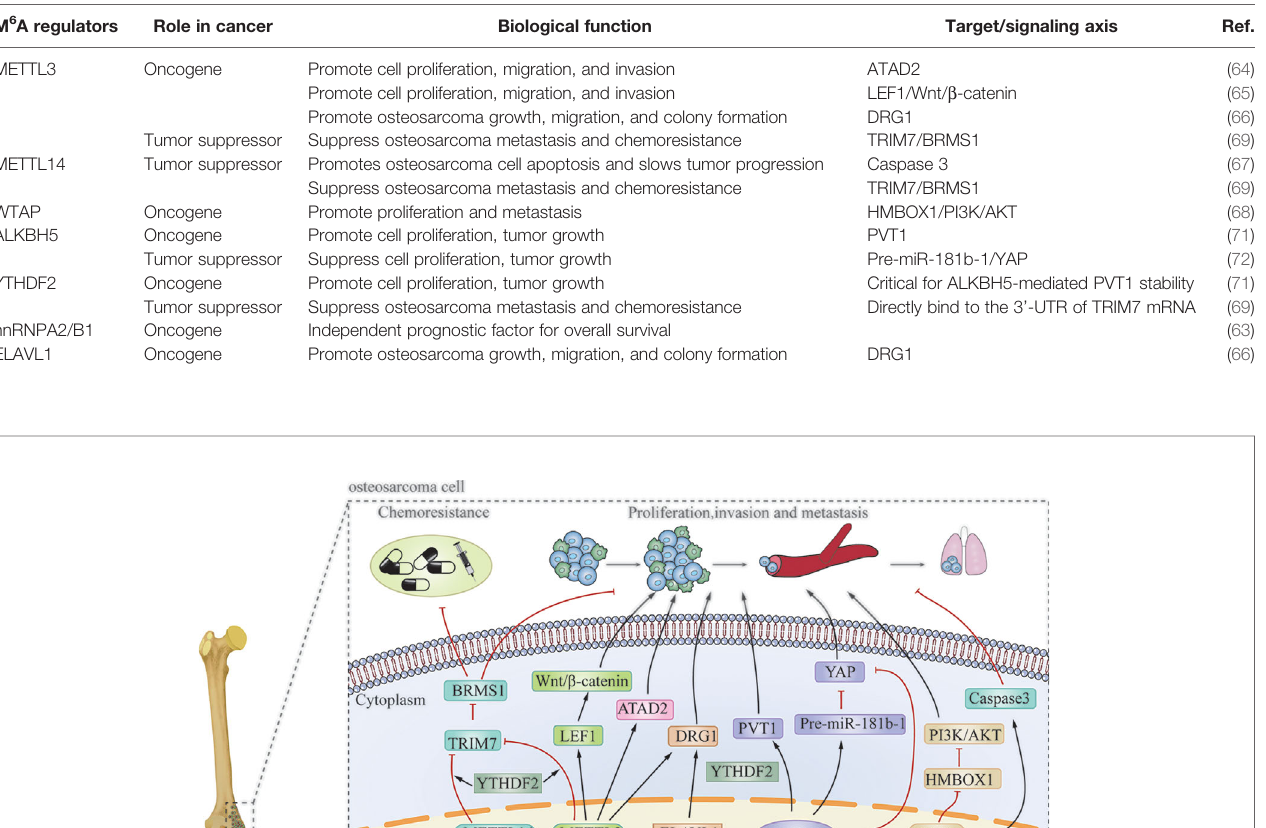
TABLE 1 | Roles of m 6 A regulators in